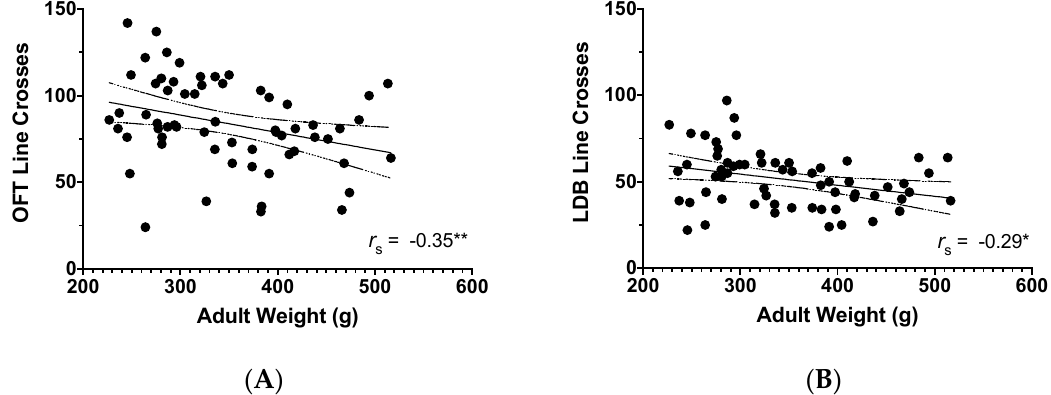
Figure 8. Scatterplot of the relationship between adult weight (g) and: ( A ) Line crosses in the open field test; ( B ) Line crosses in the light–dark box. * p < 0.05, ** p < 0.01, including 95% confidence bands of the best fit lines.